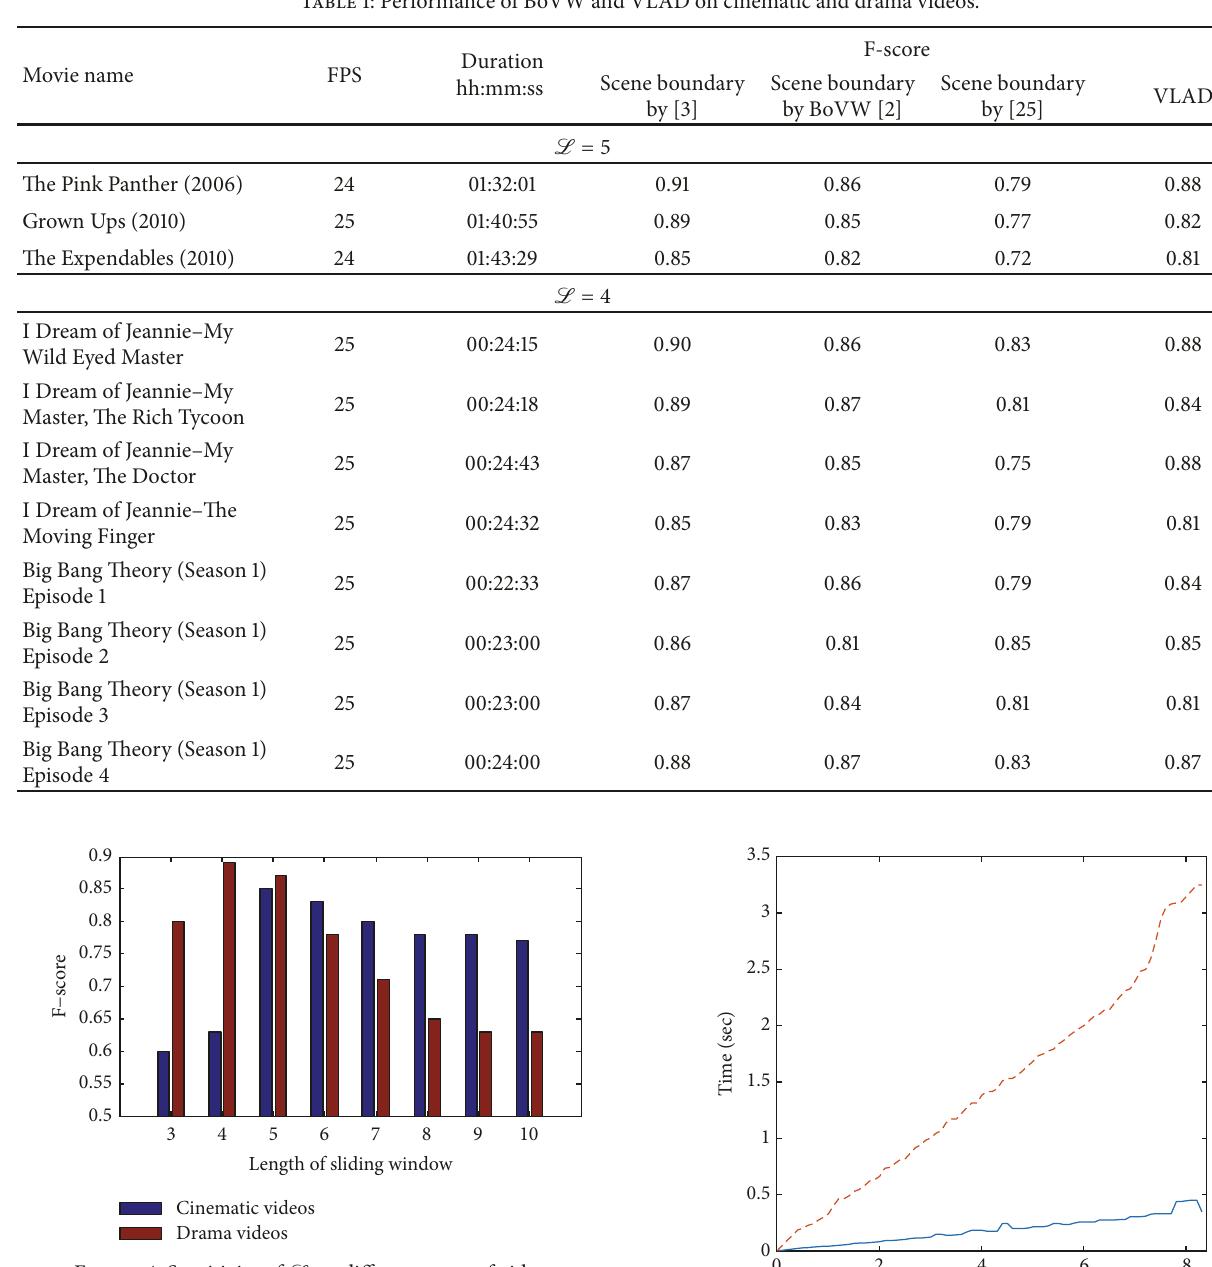
Figure 4: Sensitivity of L on different types of videos.